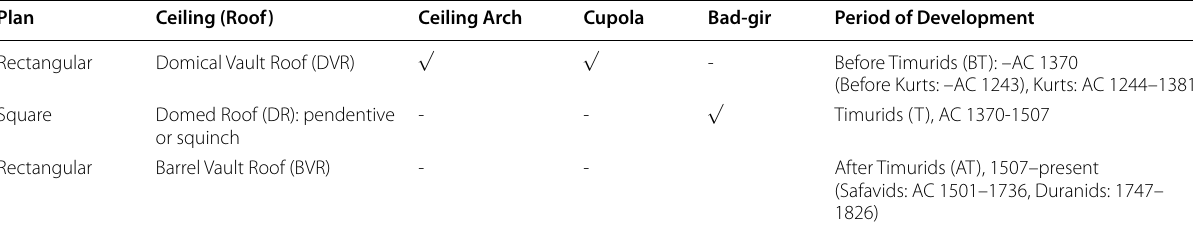
Table 1 An overview of the typology of cisterns and periods of development Plan Ceiling